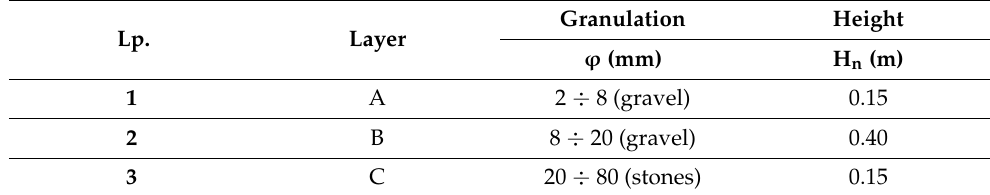
Figure 1. Cross-section of a vertical flow constructed wetland bed (layer: A — 0.15 m, B — 0.40 m and C — 0.15 m). C—0.15 m). Table 1. Characteristics of the bed